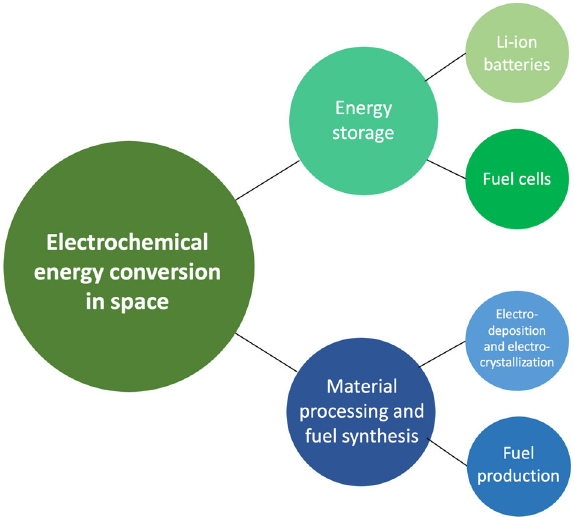
Fig. 1 Overview of electrochemical energy conversion topics discussed in this